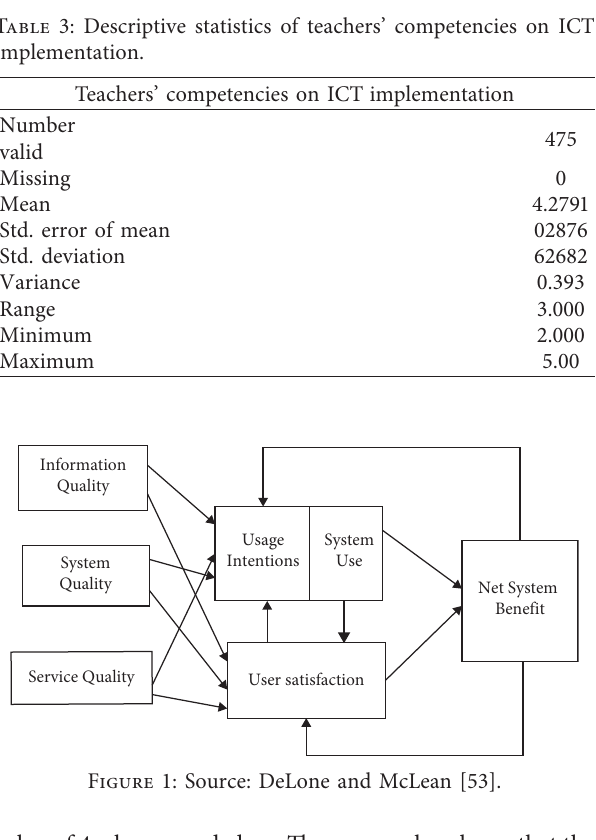
Table 3: Descriptive statistics of teachers’ competencies on ICT